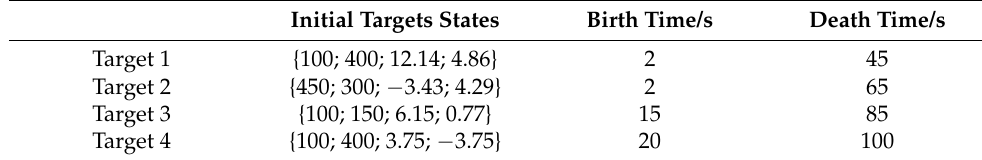
Table 1. The information of true targets.